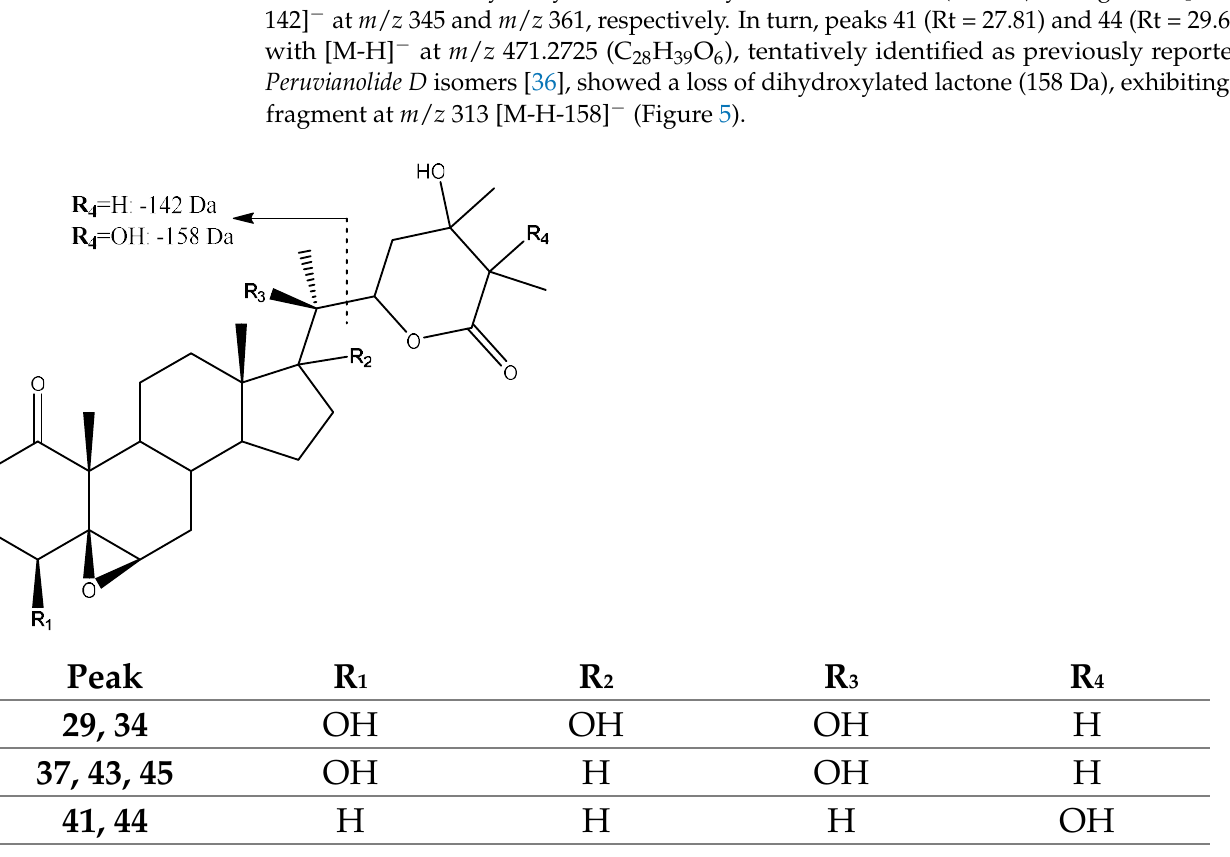
Figure 5. Structure and fragmentation of withanolide D derivatives with hydrogenated lactone.